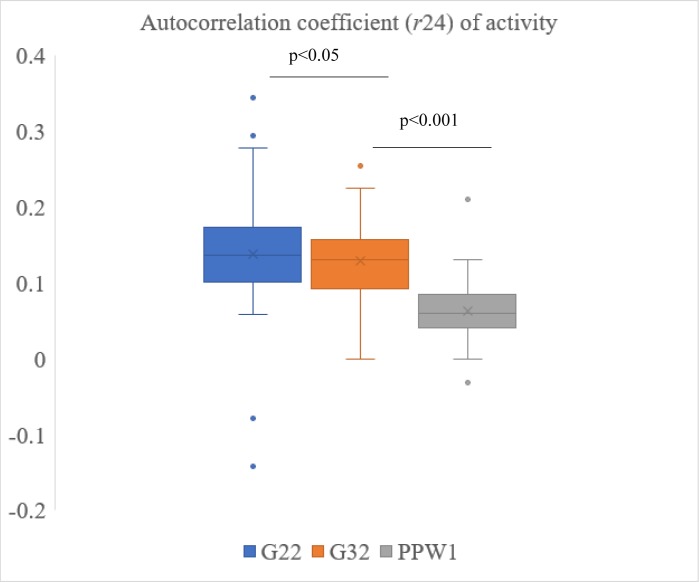
The 24 h autocorrelation coefficient (r24) of rest-activity data during gestational week 22 (G22) and 32 (G32) and postpartum week 1 (PPW1) calculated using 30 sec epochs.Repeated measures ANOVA was used to determine effect of gestational or postpartum time point on r24, followed by Bonferoni adjustments for multiple comparisons.